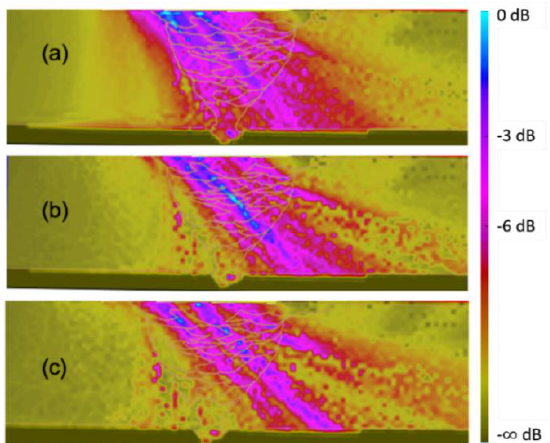
Figure 10. Longitudinal wave inspection. Scanning angle of 52°, index 18 mm. Number of elements: ( a ) 16, ( b ) 24 and ( c ) 32.